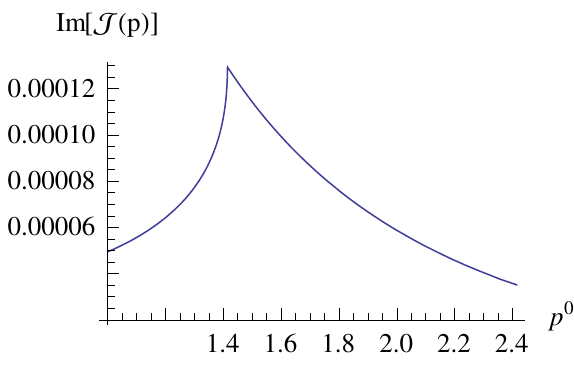
Figure 13 . Plot of Im[